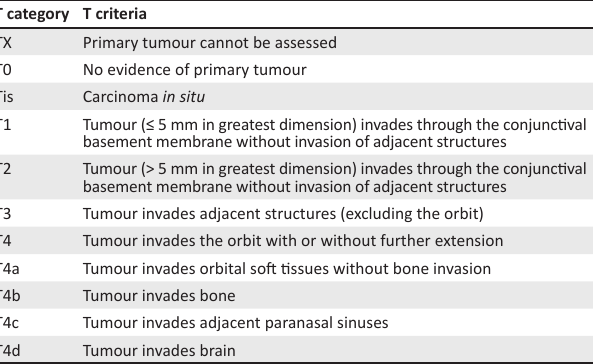
TABLE 1: American Joint Committee on Cancer staging for ocular surface squamous